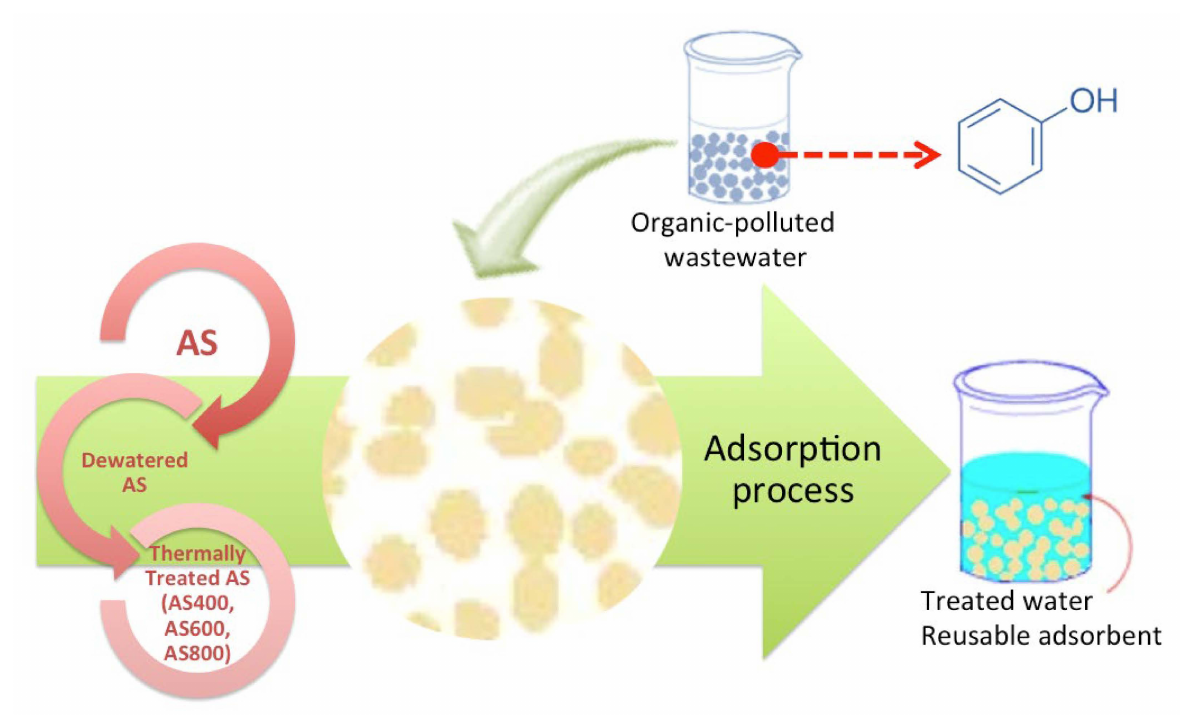
Figure 3. Graphical representation of the experimental